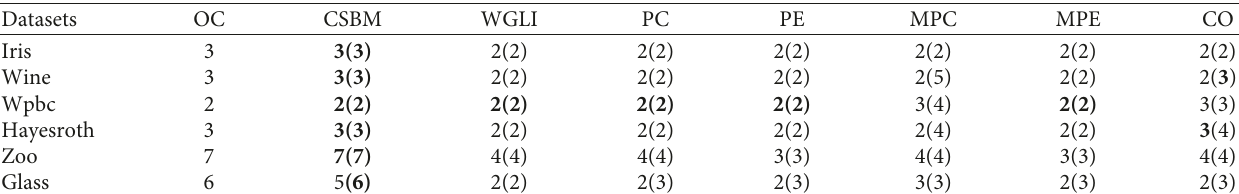
Table 9: The original classification number of each dataset and the optimal number of clusters determined by each index before and after adding noise